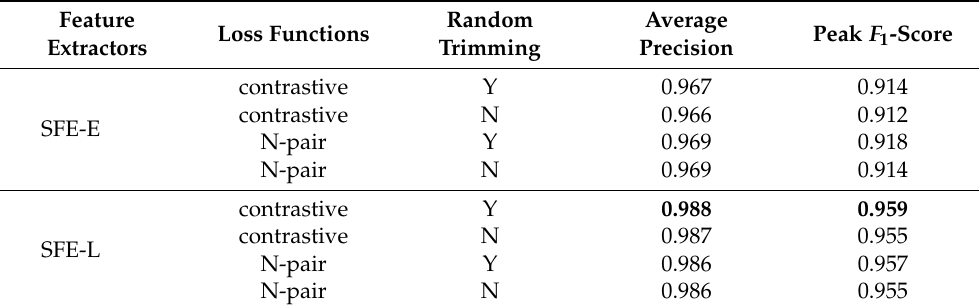
Table 1. Performance of facial motion verification with different experimental settings.